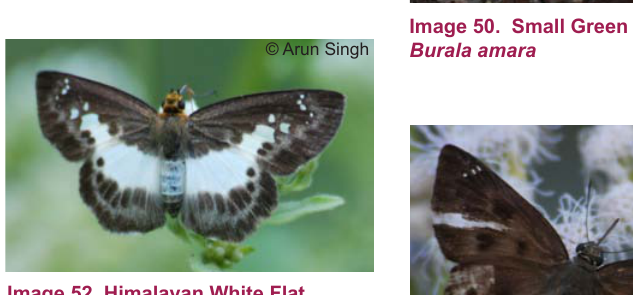
Image 52. Himalayan White Flat Seseria